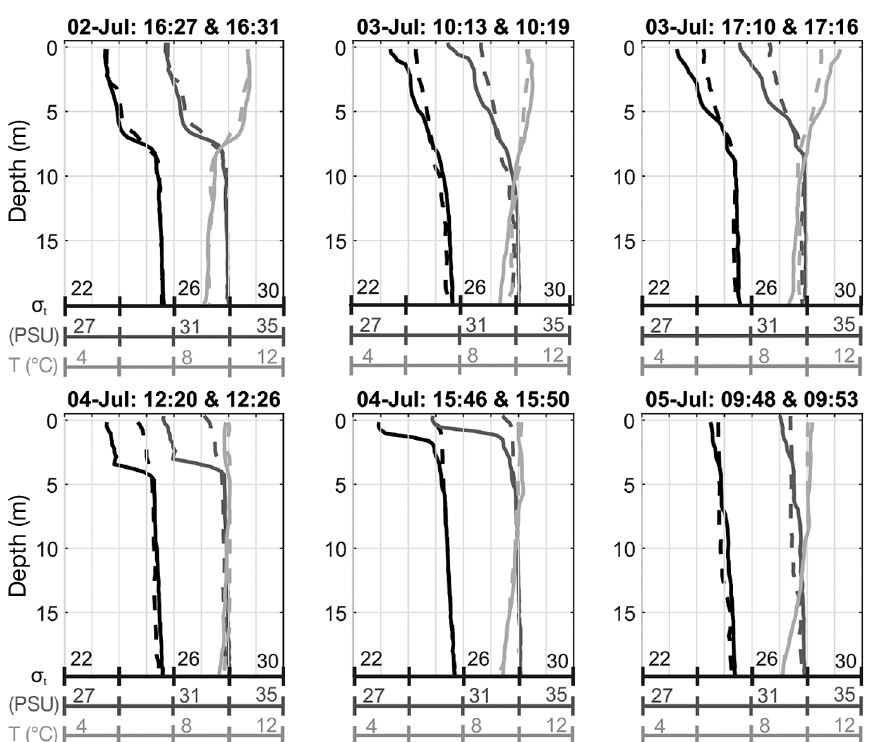
cage (Fig. 7). To give an indication of how the den- sity gradient changed with time, the depth at which inside was less than 0.2 is indicated in Fig. 6. Dur-